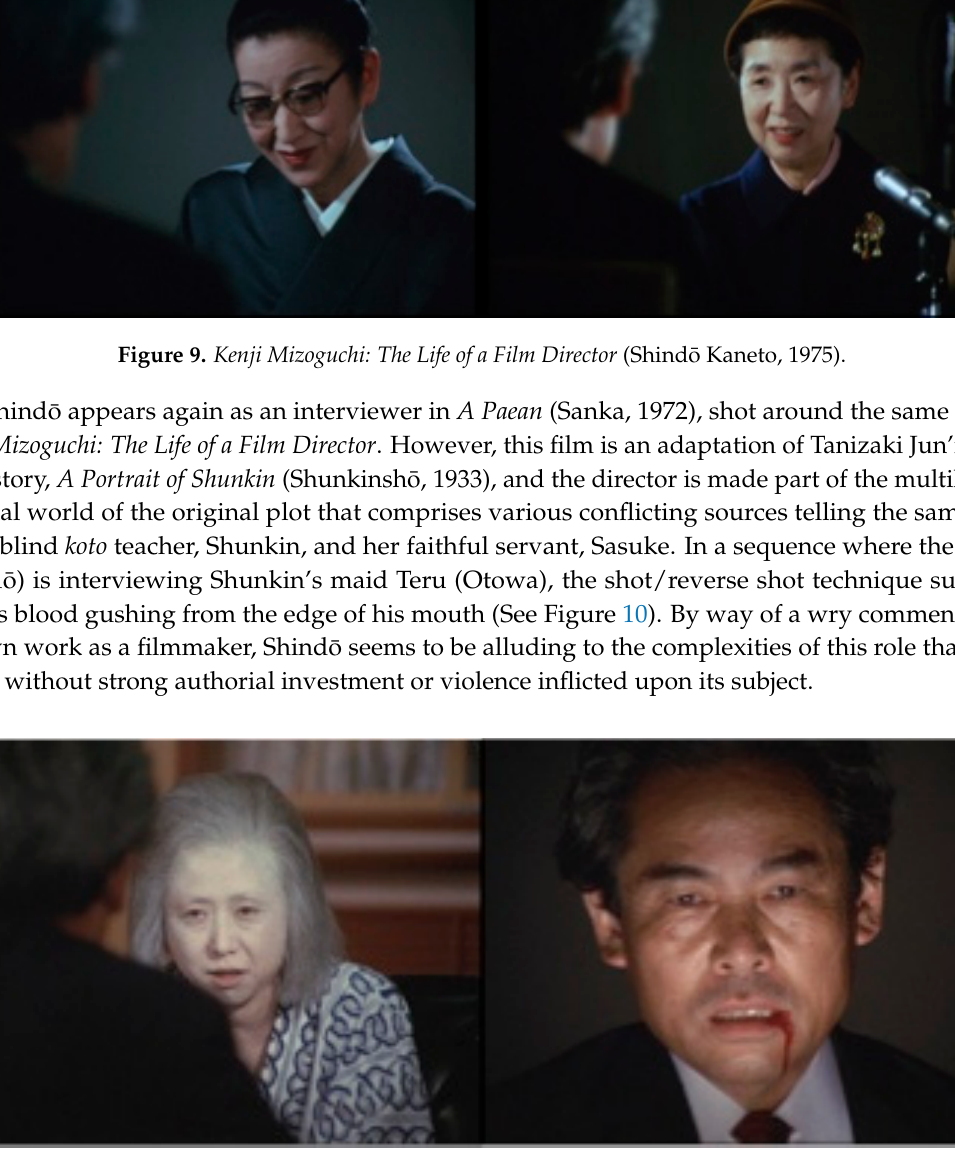
Figure 10. A Paean (Shind ō Kaneto, 1972) .